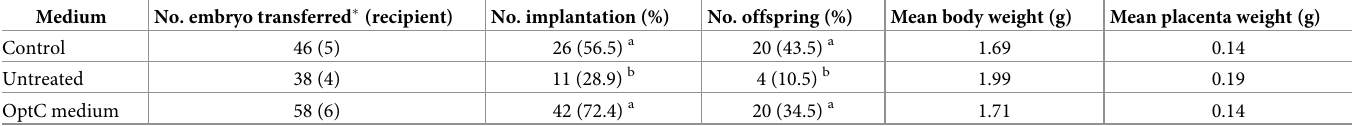
Table 3. Birth of offspring using a sealed tube with OptC medium. Medium